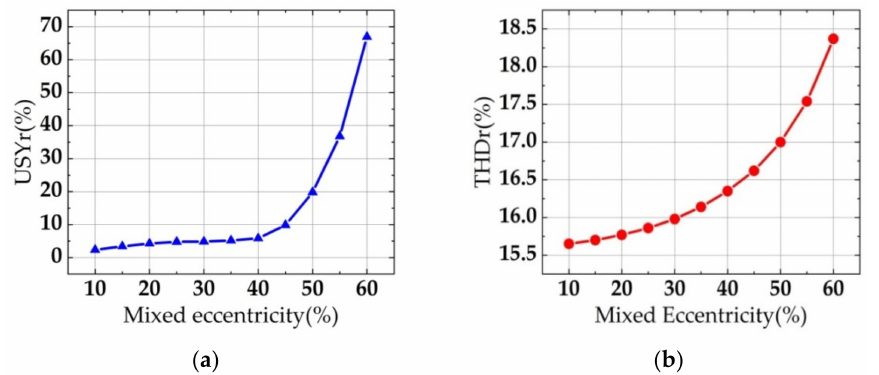
Figure 7. The values of USYr and THDr . ( a ) USYr ; ( b ) THDr .